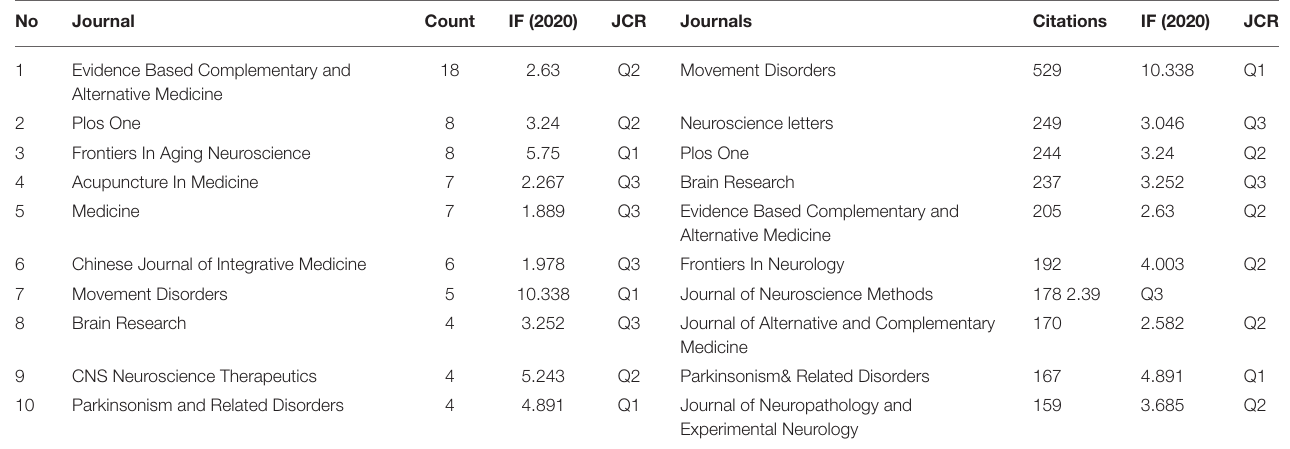
TABLE 4 | Top 10 journals for publications on acupuncture for